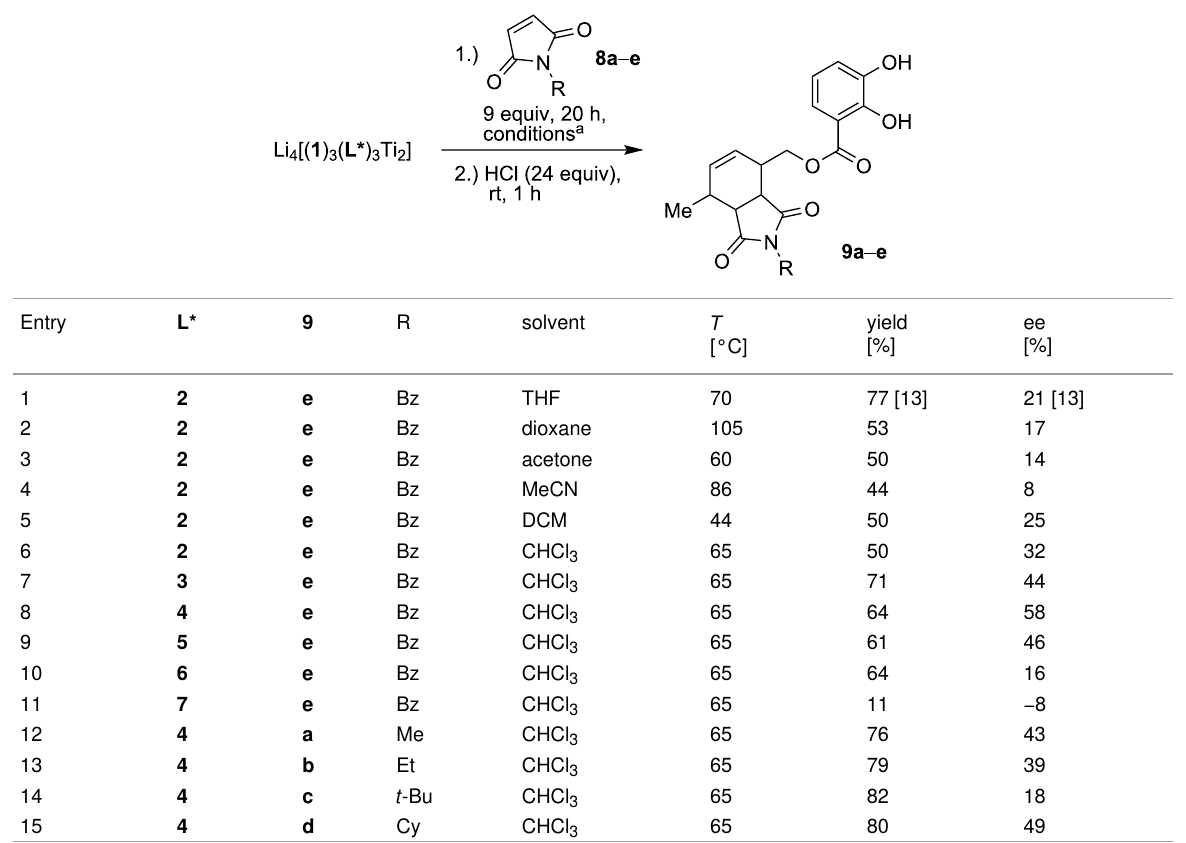
Table 1: Optimization of the stereoselectivity achieved of the Diels-Alder reaction at hierarchical helicates with solvent and chiral ligand screening.